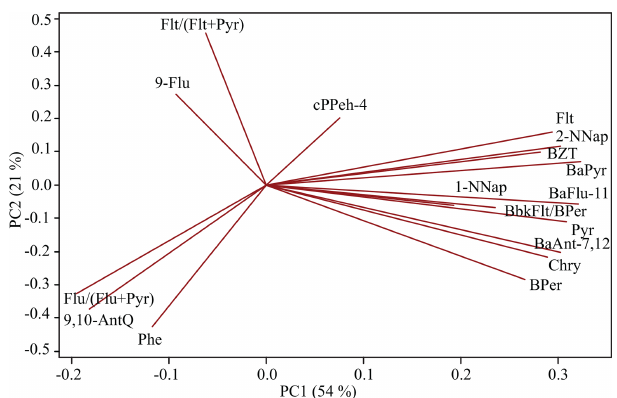
Figure 5. Principal component analysis loading plot of PC1 and PC2 for UNIS samples (G + P; n =